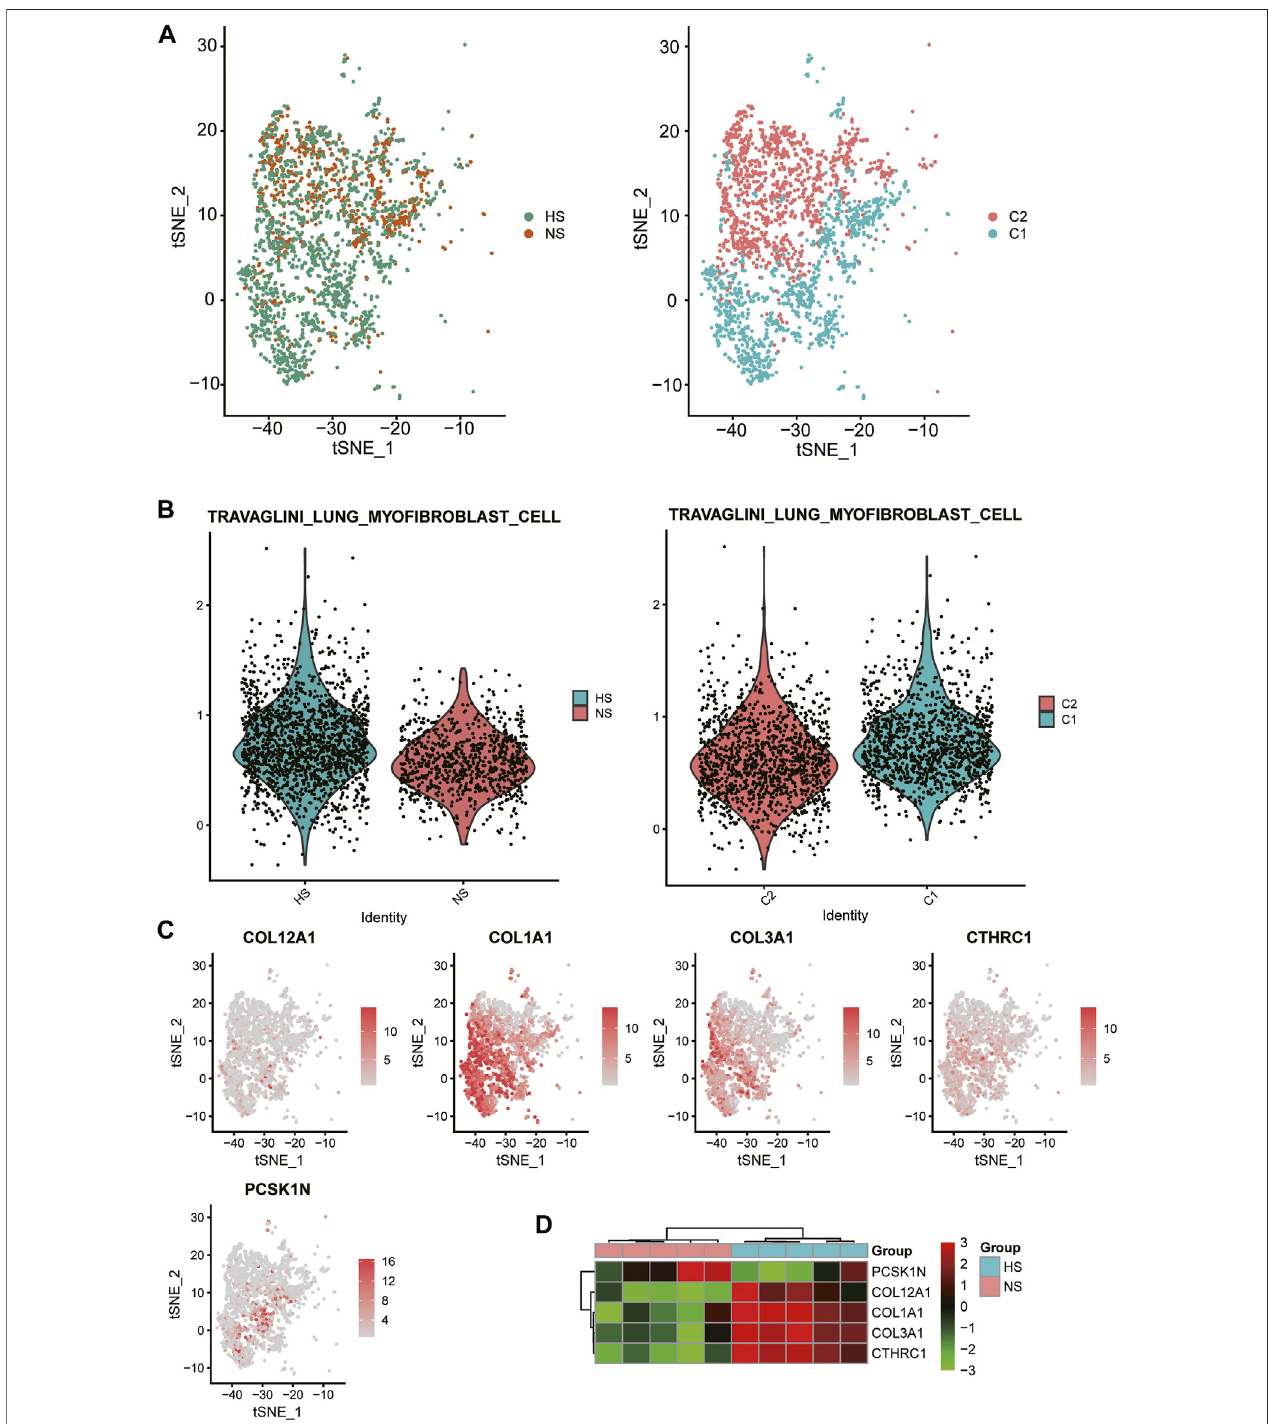
FIGURE4| Biological functionofHS-related FB-1 cluster. (A) Theclusteringofthe HSand normal skin (NS)-relatedFB-1 cells grouped bydisease (HS vsNS) and graph-based classi fi cation (C1 vs C2), respectively. (B) The differential module score of myo fi broblast cells between HS and NS, and C1 and C2. (C) The expression levels of myo fi broblast cell marker genes including COL12A1, COL1A1, COL3A1, CTHRC1, and PCSK1N in the HB-1 cells. (D) The differential expression levels of the myo fi broblast cell marker genes between HS and NS bulk samples.